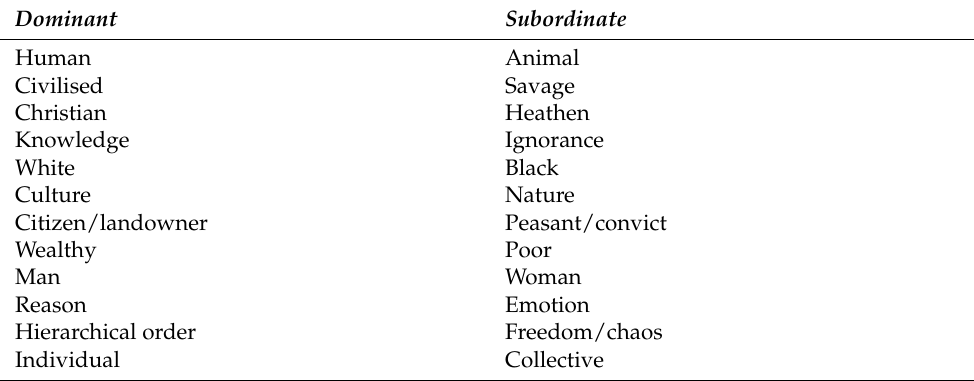
Table 1. Binaries that structure the social-material